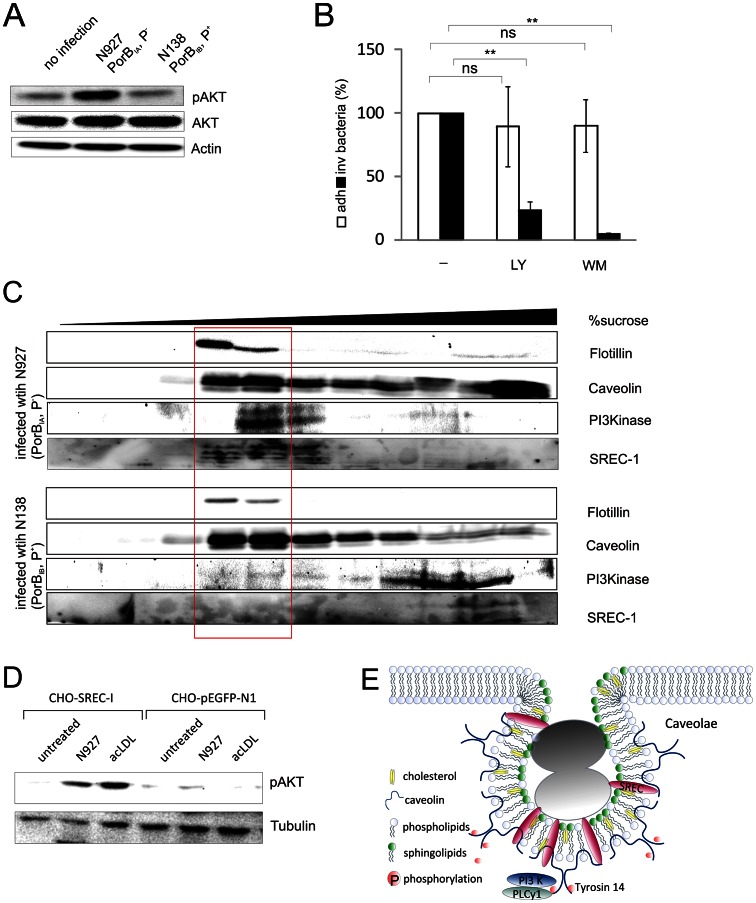
PI3 kinase is required for N927 invasion and is recruited to caveolae.(A) Activation of PI3K shown by phosphorylation of Akt. Whole cell lysates of Chang cells infected with either N927 (PorBIA, P−) or N138 (PorBIB, P+) at an MOI 50 for 30 min were subjected to SDS PAGE and Western blot using anti-phospho-Akt, anti-Akt and anti-Actin antibodies. (B) Chang cells were pretreated for 1 h with PI3K inhibitors LY294002 (LY, 10 µM) or Wortmannin (WM, 1 µM) and infected with N927 (MOI 10, 30 min). Adherence (white bars) and invasion (black bars) were quantified by gentamicin protection assay. The number of adherent and invasive bacteria of untreated control cells was set as 100%. The graph shows mean values ± SD of three independent experiments performed in duplicates. p<0.01: ** (C) Distribution of signaling molecules in membrane rafts of infected cells. Chang cells were subjected to subcellular fractionation after infection either with N927 (PorBIA, P−) or N138 (PorBIB, P+) (MOI 20) for 1 h (see Text S1). Flotillin was detected as marker for the membrane raft fraction (fraction 4–5) separated from most cellular proteins (fraction 8–12). Caveolin, SREC-I (multiple bands represent differentially glycosylated forms), Flotillin and PI3K, were detected by Western blot analysis. (D) CHO cells stably transfected with either SREC-I WT (CHO-SREC-I) or empty vector control (CHO-pEGFP-N1) were infected with N927 (PorBIA, P−) at an MOI of 50 or treated with 2 µg/ml acLDL (Invitrogen) for 5 min. Whole cell lysates were subjected to SDS-PAGE and Western blot analysis using anti-phospho-Akt and anti-Tubulin antibodies. (E) Graphical representation of SREC-I gonococci interaction in Caveolae. Upon infection with N927 SREC-I localizes in cholesterol, sphingolipid and caveolin-1 rich membrane rafts. PLCy1 and PI3K are recruited to phosphorylated Cav1 (Tyrosin 14) and initiate the signaling cascade leading to endocytic uptake of the gonococci. Adapted from [25].